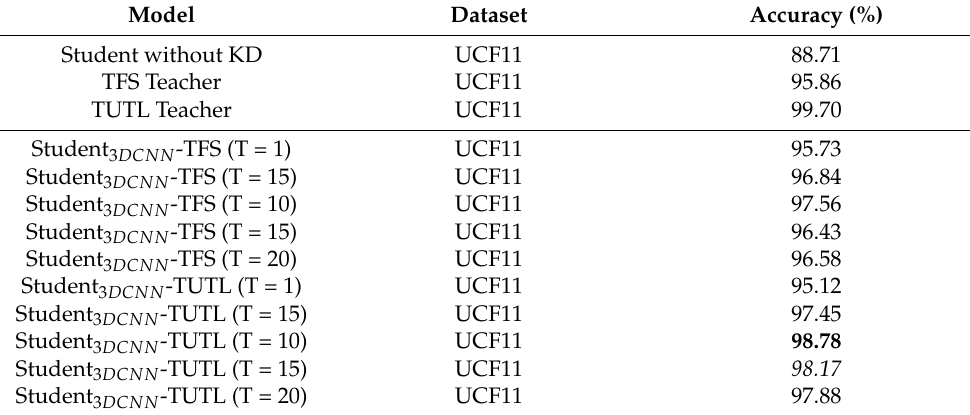
Table 3. Quantitative comparative analysis of the results obtained by our proposed framework with and without knowledge distillation (KD) with different settings over UCF11 dataset.